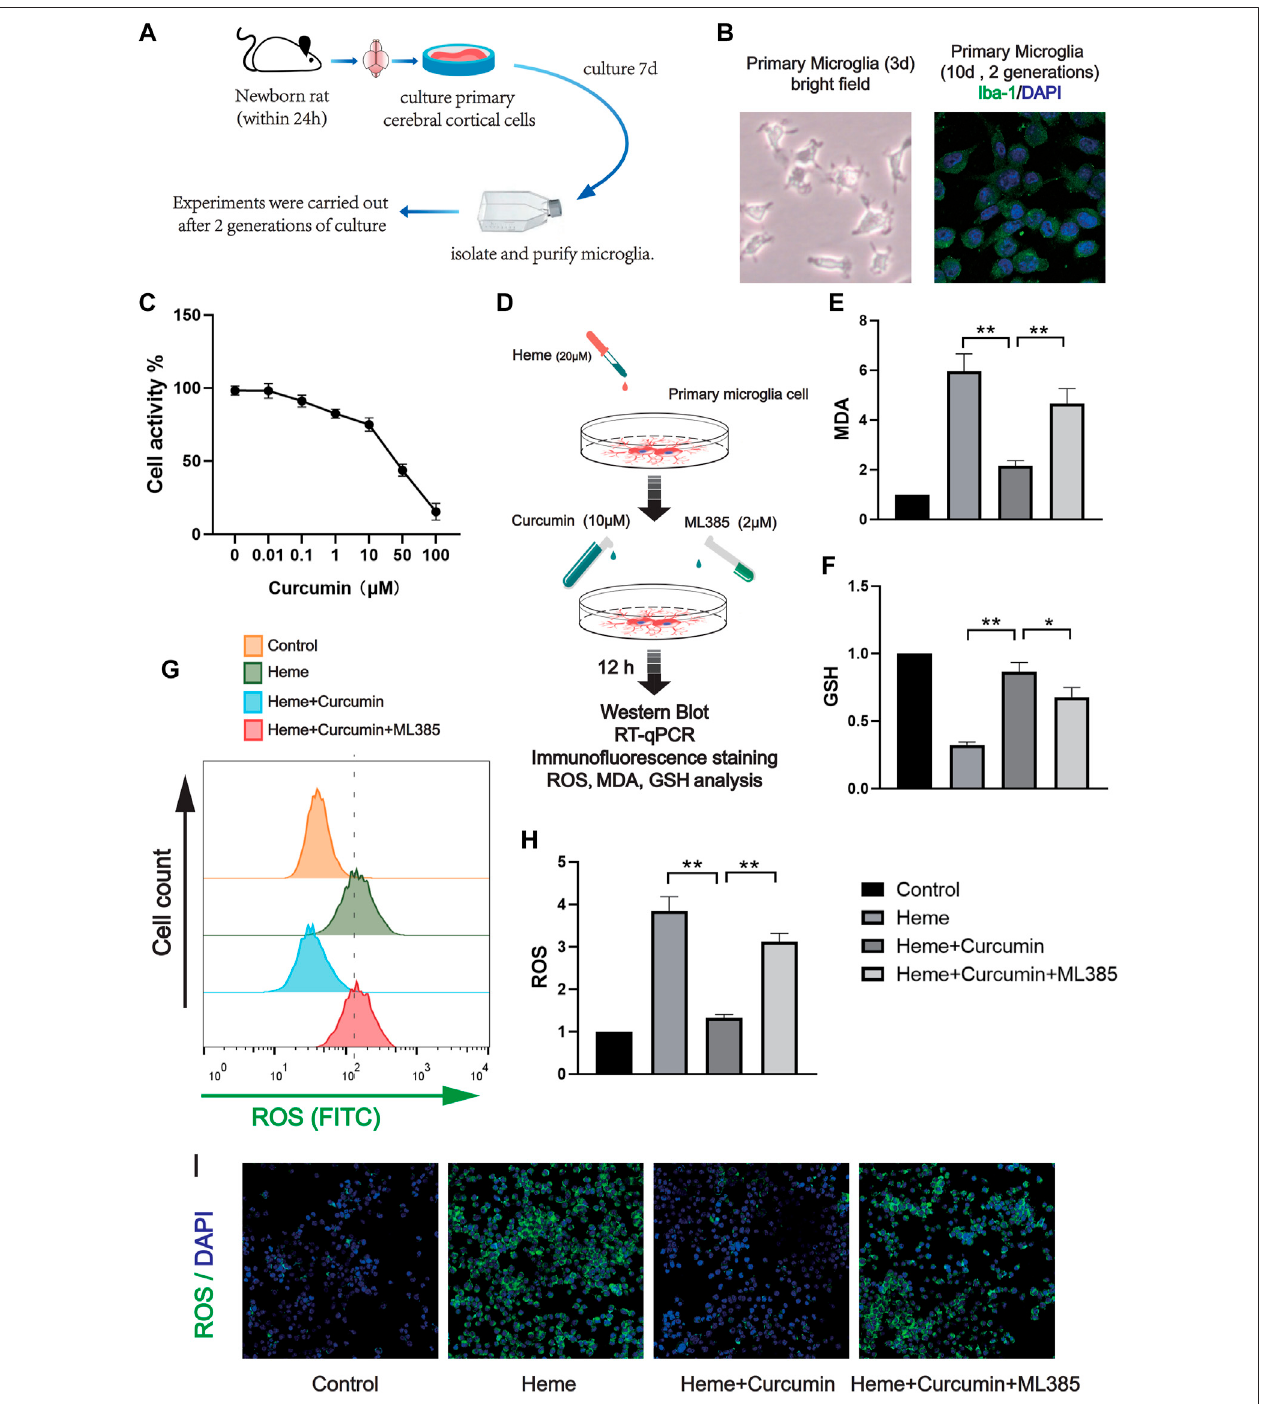
FIGURE 4 | Curcumin was con fi rmed to promote the antioxidant function of rat primary microglia. (A) The activity of the primary microglia treated with curcumin at different concentrations for 12 h was determined, and the cellular activity of the cells was evaluated by the CCK-8 analysis. (B) In vitro experimental procedures. (C,D) BasedontheCCK-8analysis,heme-induced primarymicrogliaweretreatedwithcurcumin(10 μ M)for12 h,thenthelevelsofMDAandGSH weredetermined. (E) After ROS in each group were labeled by FITC, fl ow cytometry results were performed. (F) ROS levels in primary microglia were measured with a microplate reader. (I) Intracellular ROS levels were analyzed using the ROS Assay Kit and the results were presented using confocal fl uorescence images, in which FITC labeled intracellular ROS. The data are shown as the means ± SD of n = 3 samples/group and at least three independent experiments were performed. The statistical analyses were conducted using the two-way ANOVA. *, p < 0.01 and **, p < 0.01.